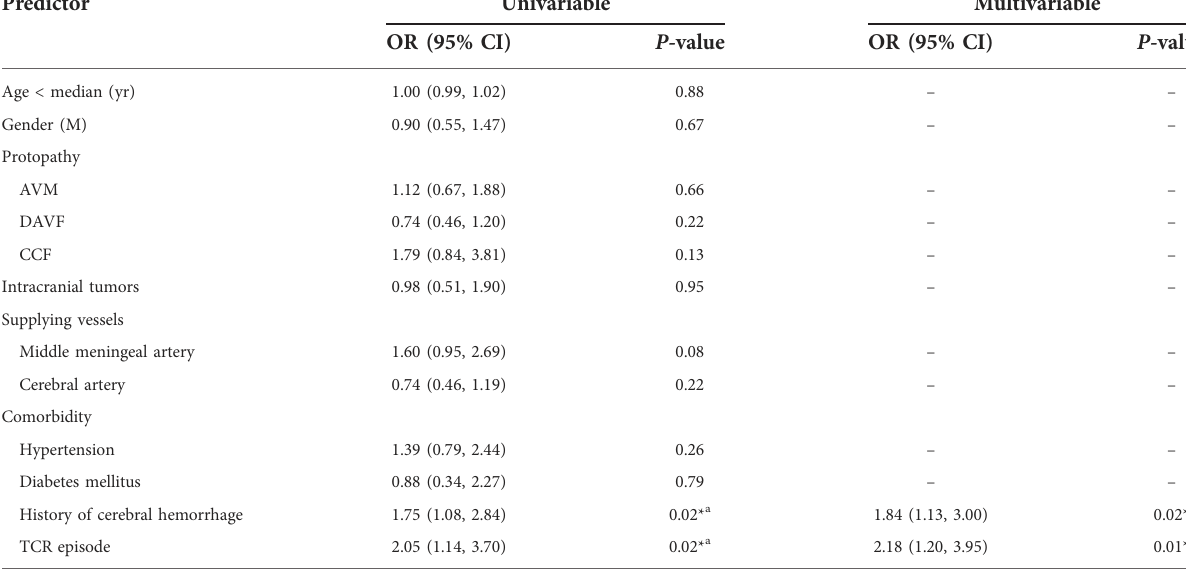
TABLE 4 Univariate and multivariate logistic regression analysis of postoperative adverse events.